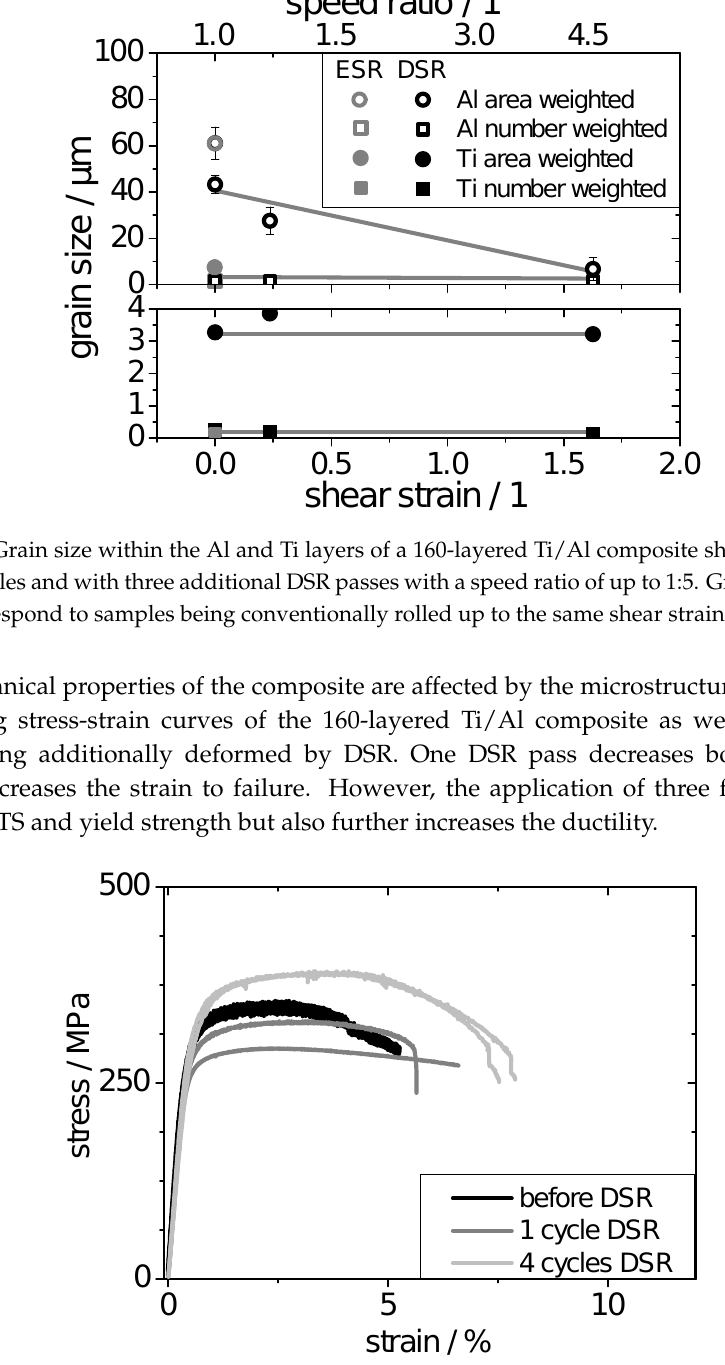
Figure 14. Engineering tensile stress-strain curves of 160-layered Ti/Al composite sheets as well as those with subsequent DSR being applied with a speed ratio of 1.1. Results are shown for one and four DSR passes. Results for two samples in each condition are shown in order to illustrate the occurring